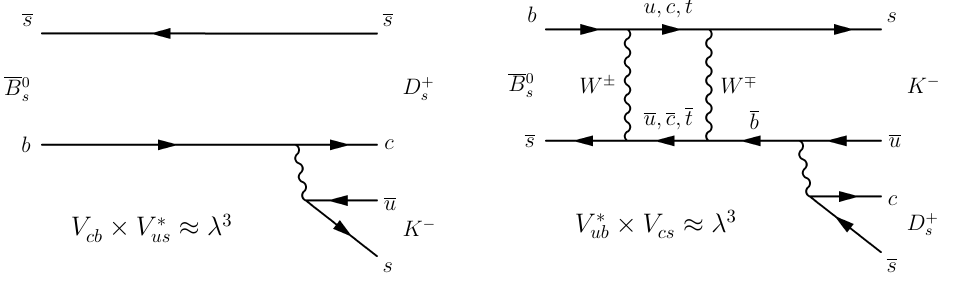
Figure 1 . Feynman diagrams for B 0